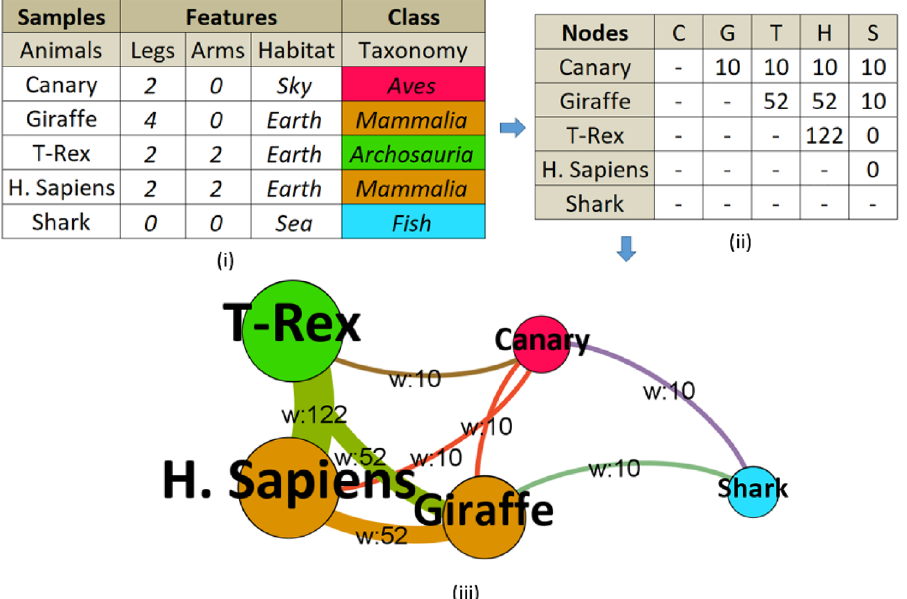
Figure 3. (i) Tabular data converted to adjacency (similarity) matrix (ii), and graph (iii) constructed and enriched with node degrees, edge weights, and colored by communities (classes). Layout graph intuitively shows the importance of some nodes (i.e., H. Sapiens and T-Rex have the highest number of weighted connections, therefore, larger in size) and visually depicts how similar nodes are (e.g., Shark has the smallest similarity to other nodes so it is distant from the